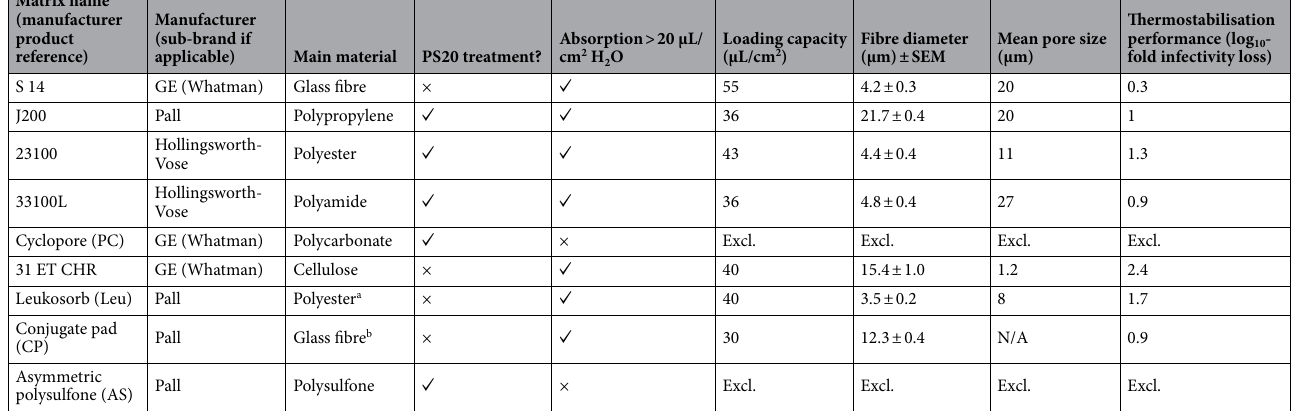
Table 1. Basic characteristics of studied matrices. Loading capacity was measured by weight measurement of matrices before and after full impregnation in water. Fibre diameter was measured using Image J from SEM micrograph images. Mean pore size are as provided in suppliers’ specification (in one case N/A denotes data not available). Thermostabilisation performance presented is loss of infectivity after vaccine drying and thermochallenge for 1 week at 45 °C. Excl. denotes matrices excluded from further analysis on basis of loading capacity. a Proprietary composition, but macroscopic, microscopic and FTIR spectrum appearances are consistent with polyester (data not shown); this matrix is henceforth referred to as polyester. b Henceforth referred to as ‘glass fibre (conjugate pad)’ for avoidance of confusion with S14.